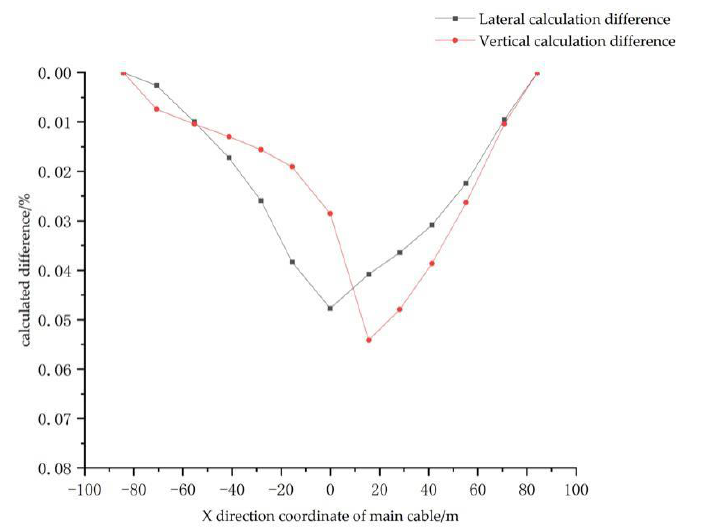
Figure 7. Finite Element Model of Bridge.